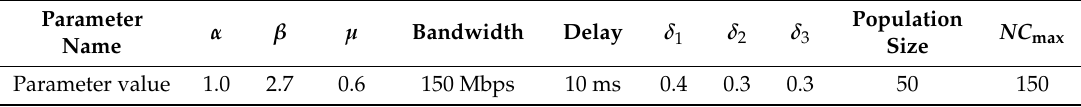
Table 4. Simulation experiment test